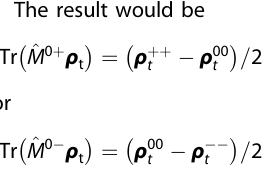
Fig. 2 Tomography of the density matrix. a Pulse sequence for the preparation and density matrix tomography of ψ and imaginary parts of the density matrices of ( b , c ) ψ 1 j i and ( d , e ) ψ 2 j i , with deviations from the ideal values represented by the dashed yellow